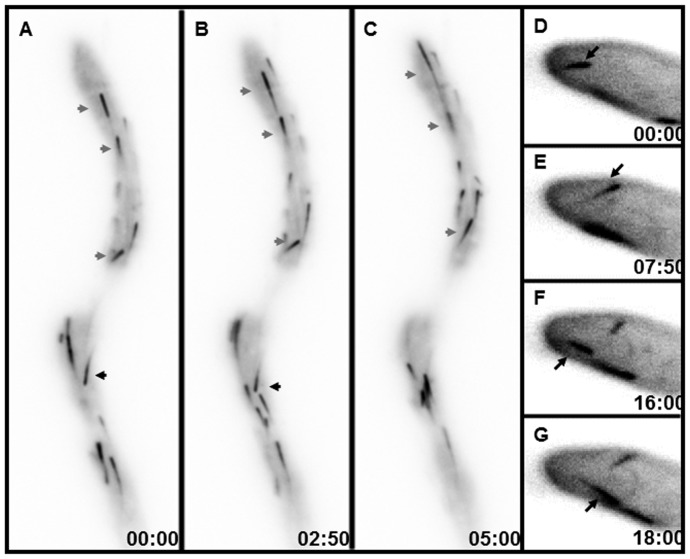
TIRFM of MTB-3-GFP in the cortex of mature hyphae.(A–C) Apical and subapical regions. (D–G) Enlargement of apical regions. Grey arrows point to MTB-3-GFP comets moving in anterograde direction, and black arrows point to comets that move in retrograde direction. Time scale is in sec∶msec. Scale bars = 10 µm.